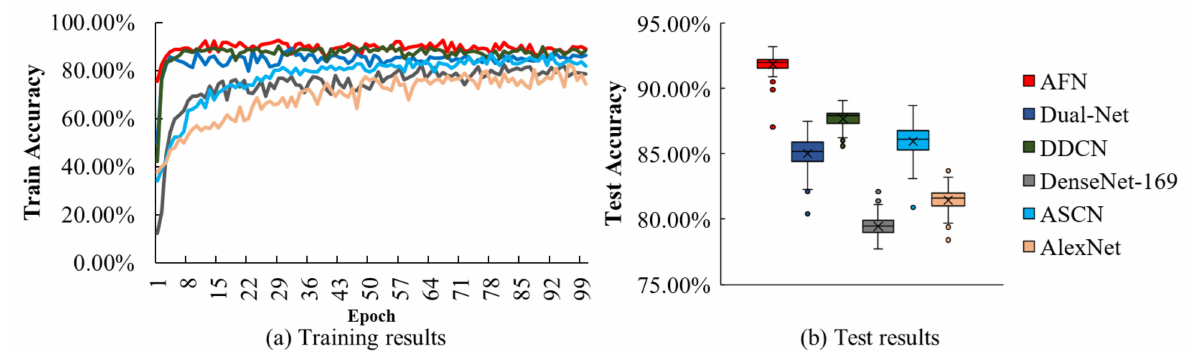
Figure 7. Results of ( a ) training curves and ( b ) test box plot on FF_Smoke dataset. The line in the box of Figure 7b shows the median; the cross indicates the mean; the box extends from the first quartile to the third quartile; the whisker extends from the box by an inter-quartile range of 1.5; and the outliers are marked with a